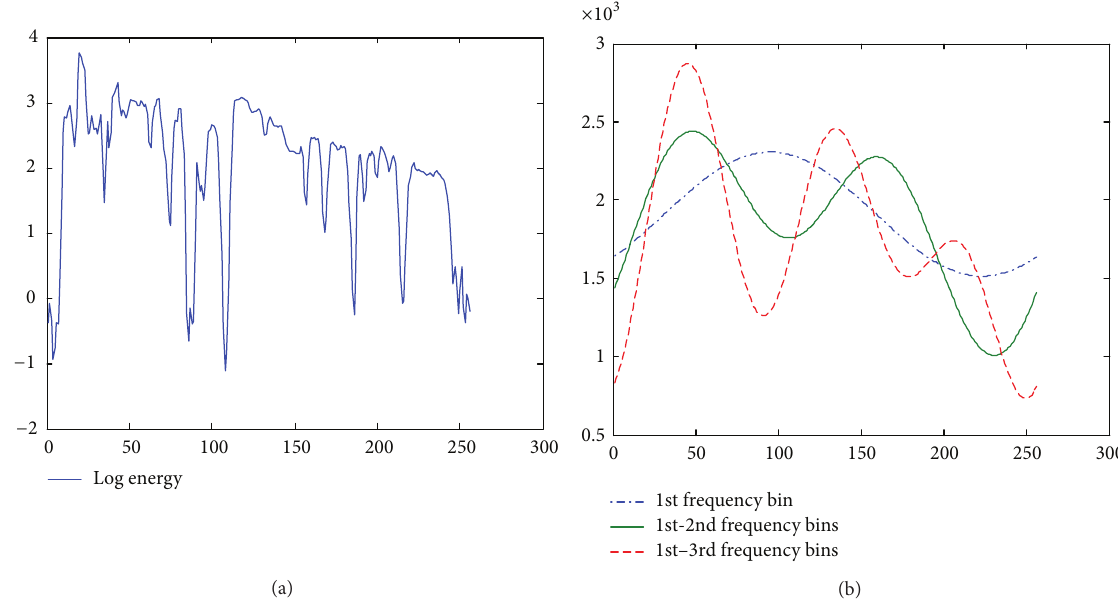
Figure 4: Examples of approximated LFE contours from a bored speech